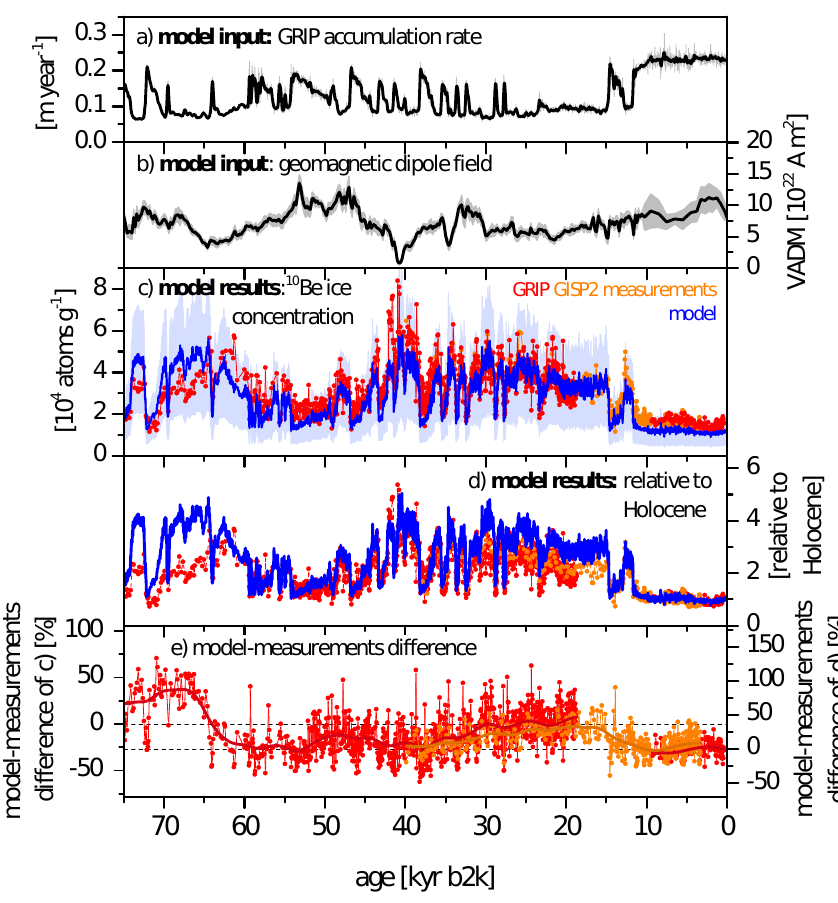
Figure 7. Model results of the 10 Be ice concentration at Greenland Summit compared to respective ice core measurements. (a) and (b) show the model input data driving the temporal variation of the model results: GRIP accumulation and geomagnetic dipole field strength (Laj et al., 2004) both on the GICC05modelext timescale (see text for details). (c) shows the 10 Be model results (blue) compared to GRIP (red dots; Yiou et al.,1997; Wagner et al., 2001a; Muscheler et al., 2004) and GISP2 (orange dots; Finkel and Nishiizumi, 1997) measurements. The blue band denotes the original model results including the seasonal cycle. Thick blue lines show yearly mean model results. (d) shows model results and measurements normalized to the Holocene period. Model–measurement differences of (c) and (d) are shown in (e) relative to measurements. Here, thick lines denote Gaussian smoothing which dampens 2000-year oscillations to